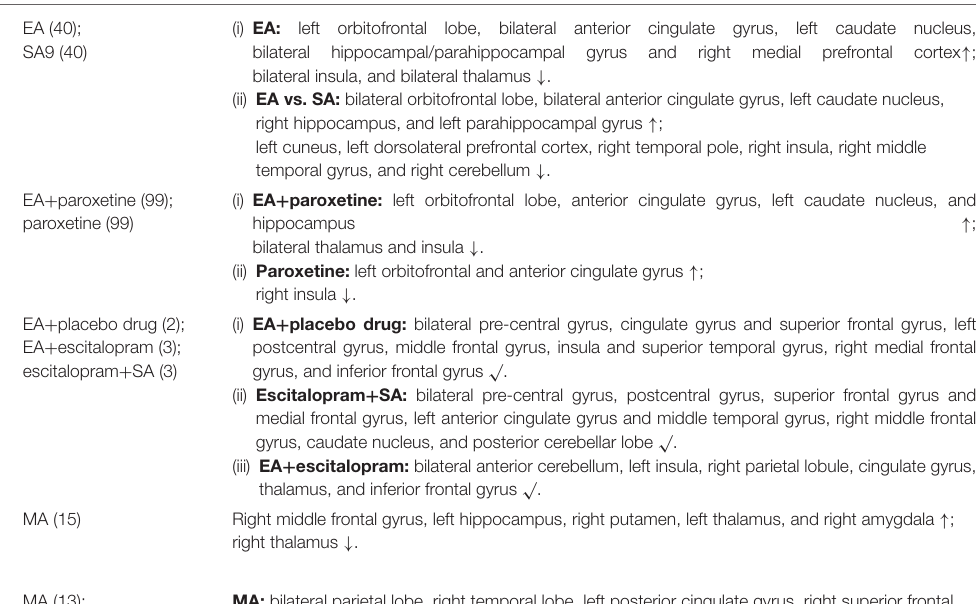
(i) EA: left orbitofrontal lobe, bilateral anterior cingulate gyrus, left caudate nucleus, bilateral hippocampal/parahippocampal gyrus and right medial prefrontal cortex ; ↑ bilateral insula, and bilateral thalamus . ↓ (ii) EA vs. SA: bilateral orbitofrontal lobe, bilateral anterior cingulate gyrus, left caudate nucleus, right hippocampus, and left parahippocampal gyrus ; ↑ left cuneus, left dorsolateral prefrontal cortex, right temporal pole, right insula, right middle temporal gyrus, and right cerebellum . ↓ (i) EA + paroxetine: left orbitofrontal lobe, anterior cingulate gyrus, left caudate nucleus, and hippocampus ; ↑ bilateral thalamus and insula . ↓ (ii) Paroxetine: left orbitofrontal and anterior cingulate gyrus ; ↑ right insula . ↓ postcentral gyrus, middle frontal gyrus, insula and superior temporal gyrus, right medial frontal gyrus, and inferior frontal gyrus √ . (ii) Escitalopram + SA: bilateral pre-central gyrus, postcentral gyrus, superior frontal gyrus and medial frontal gyrus, left anterior cingulate gyrus and middle temporal gyrus, right middle frontal gyrus, caudate nucleus, and posterior cerebellar lobe √ . (iii) EA + escitalopram: bilateral anterior cerebellum, left insula, right parietal lobule, cingulate gyrus, thalamus, and inferior frontal gyrus √ . . ↓ MA: bilateral parietal lobe, right temporal lobe, left posterior cingulate gyrus, right superior frontal gyrus, left middle frontal gyrus, and caudate nucleus . ↑ . ↓ Correlation: between brain cognitive control network and seven factor subdivision rate of HAMD-24 scale. (i) MA: For pa: rsFC between right middle occipital gyrus, left middle occipital gyrus, left anterior central gyrus, and left paracentral lobule . For ph: right superior cerebellum and the left superior ↓ cerebellum .Forwmh:rsFCbetweenleftmiddlegyrus,leftmodulelobe,leftanteriorcentralgyrus, ↓ left h-corner inferior frontal gyrus, and right posterior central gyrus . ↓ (ii) SA: For left pa and ph: -. For left vmh: rsFC between right fusiform gyrus, the right orbital superior frontal gyrus, the right glume middle gyrus, the left angular gyrus, and the right angular gyrus . ↓ (iii) MA vs. SA : For left vmh: -. Bilateral ACC ; ↑ left middle prefrontal cortex, left angular gyrus, and bilateral HIPP/paraHIPP . ↓ (i) MA + fluoxetine: For ; ↑ For right amygdala: paraphippocampus (Para)/putman (Pu) . ↑ (ii) SA + fluoxetine: For right amygdala: left Para/Pu . ↓ (iii) MA + fluoxetine vs. SA + fluoxetine: For left amygdala: left sgACC/pgACC ; ↑ For right amygdala: left Para/Pu . ↑ (iv) Correlation : negative correlation between rsFC in the amygdala-sgACC/pgACC with MADRS and